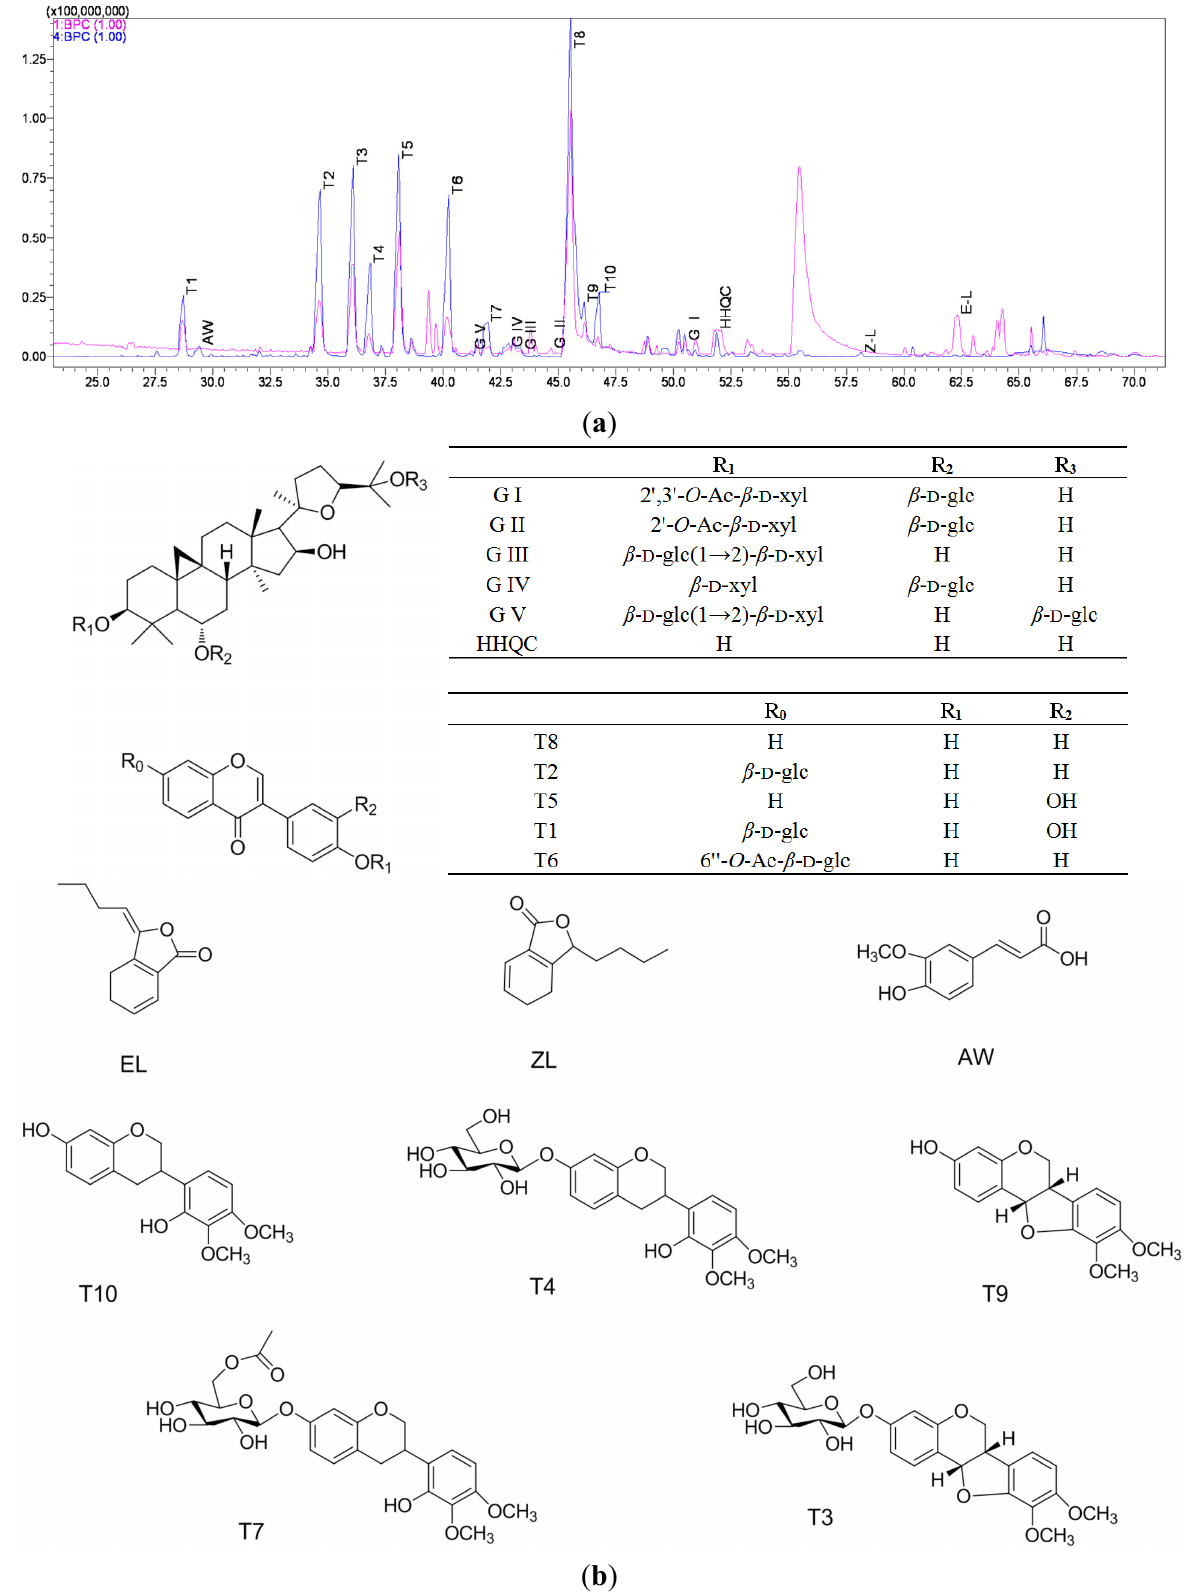
Figure 1. ( a ) LC-MS chromatogram of 19 reference compounds in PI ( 1BPC ) and NI ( 4BPC ) mode. ( b ) The chemical structures of 19 reference